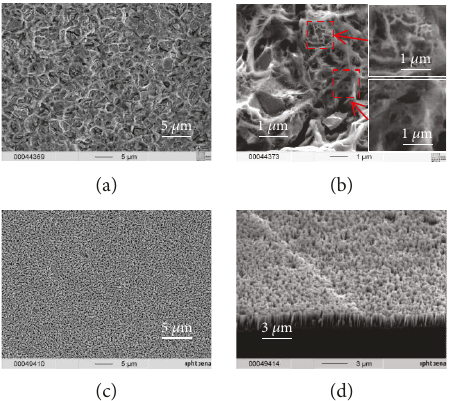
Figure 4: (a) Surface texturing of the as-cut pc-Si wafers subject to a MAWCE; (b) higher magni fi cation SEM image of the surface texture showing nanofeatures (examples in the insets are shown in the regions marked with red rectangles); (c) densely packed nanowires formed after the two-step MAWCE on polished wafers; (d) vertically orientated silicon nanowires etched by the two-step MAWCE process.